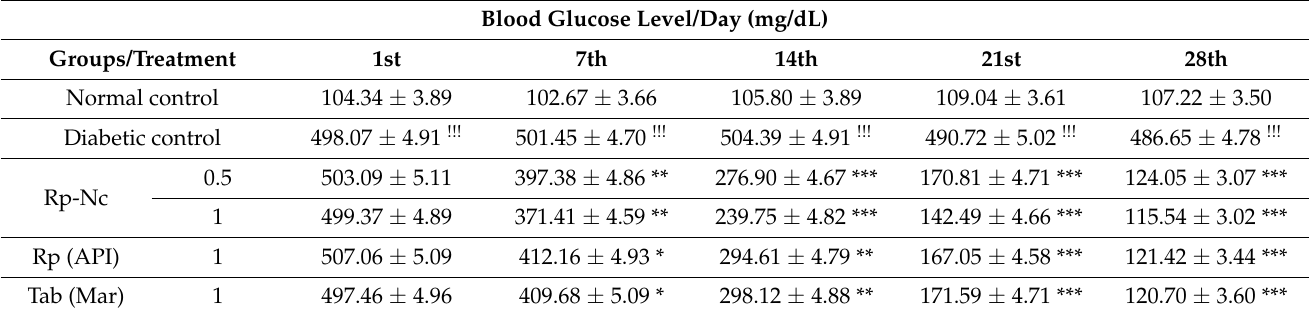
Table 3. Effect of Rp-Nc on blood glucose level. Blood Glucose Level/Day